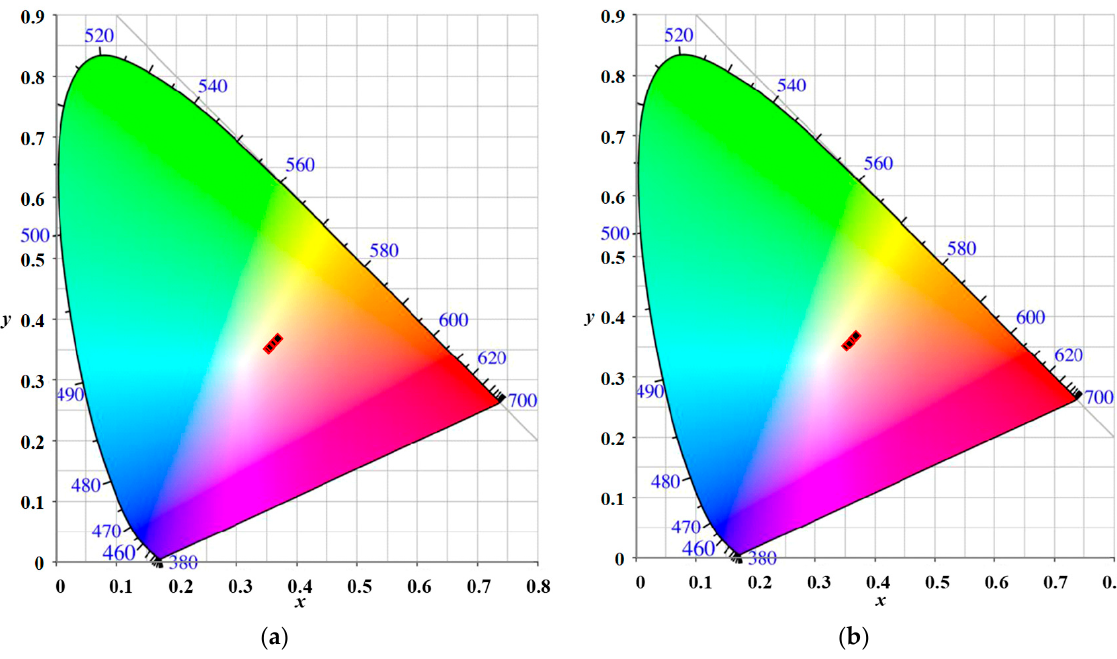
Figure 15. Measured CIE 1931 chromaticity diagrams with: ( a ) VCSR method; ( b ) VDSV method.